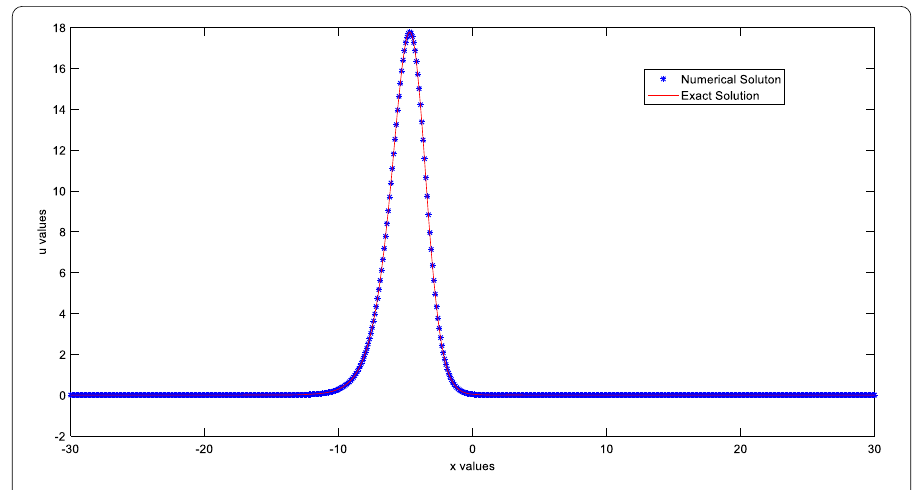
Figure 3 Example 3: Comparison between numerical and exact solutions at t =